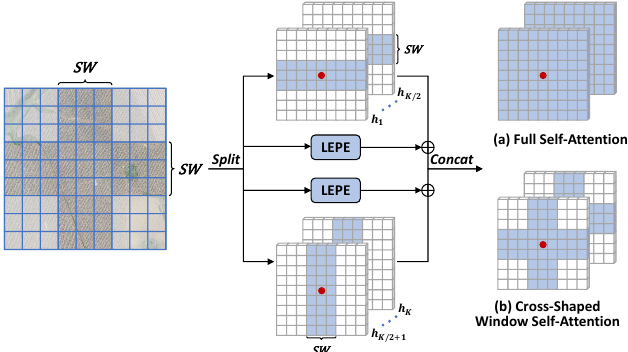
Figure 4. Explanation of the cross-shaped window self-attention.